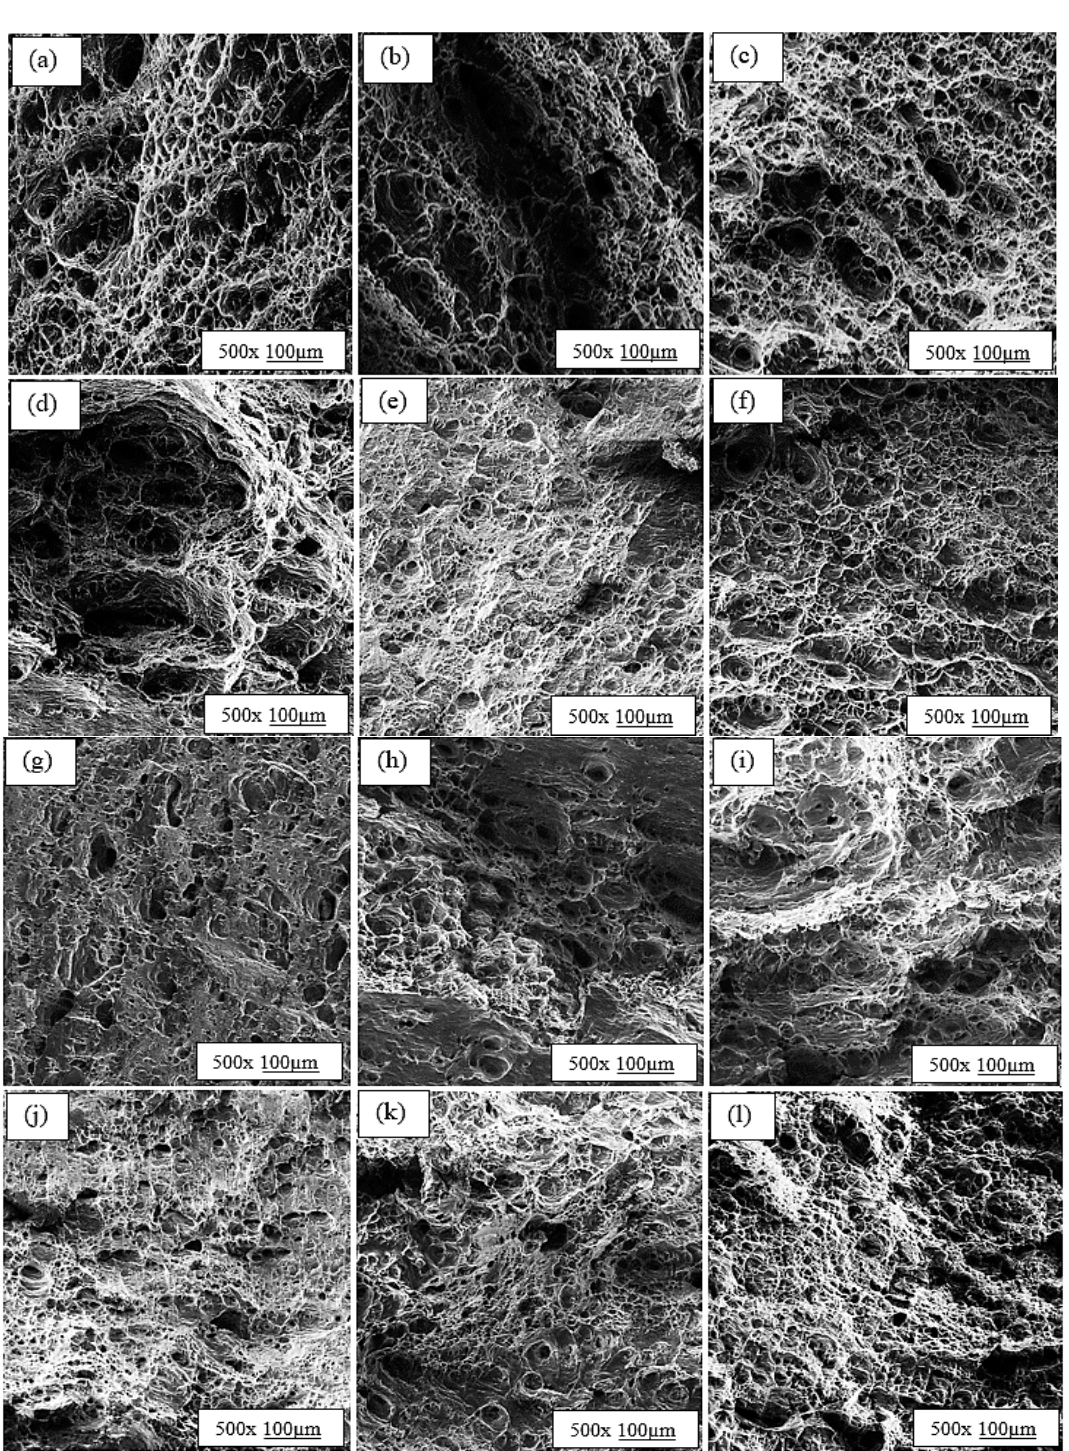
Figure 7. SEM morphologies: 1-pass ( a ) start, ( b ) middle, ( c ) end; 2-pass ( d ) start, ( e ) middle, ( f ) end; 3-pass ( g ) start, ( h ) middle, ( i ) end; 4-pass ( j ) start, ( k ) middle, ( l ) end.